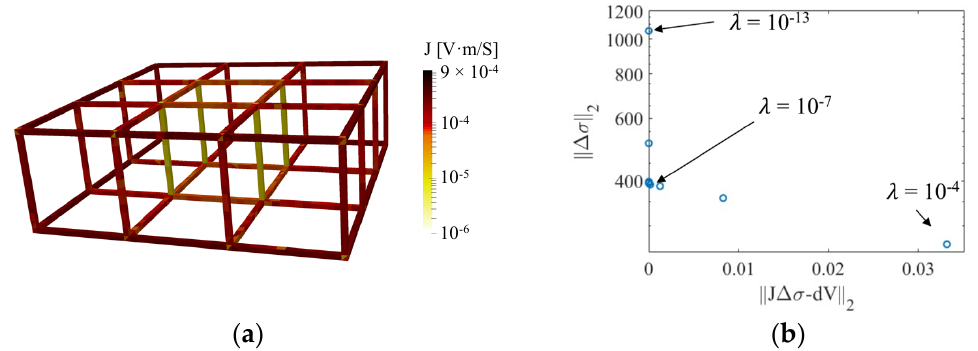
Figure 5. ( a ) The summed sensitivity map of the lattice structure was calculated. ( b ) The L-curve was plotted, with λ ranging from 10 −13 to 10 −4 .